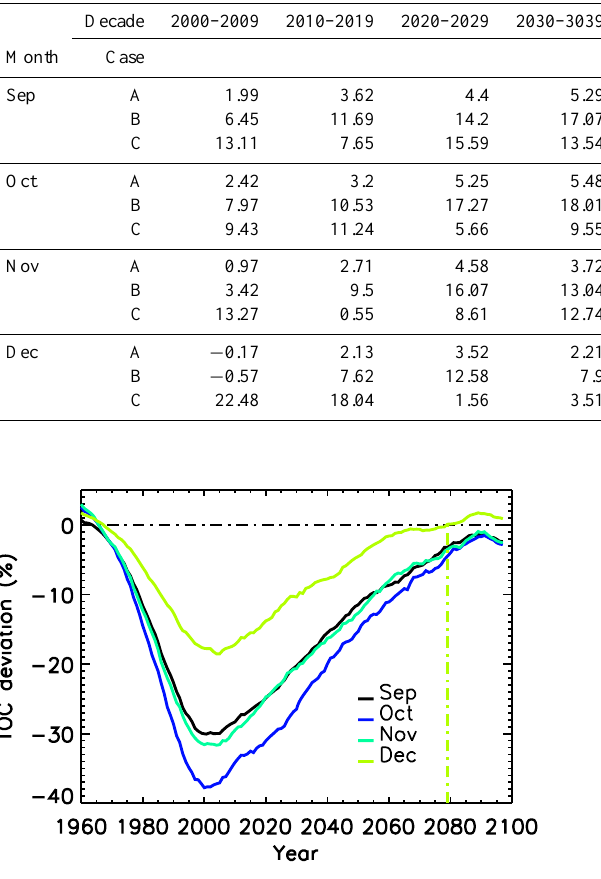
Fig. 3. Time series of multi-model TOC median values for September–December as percent deviations from the 1965 baseline. Curves have been smoothed as described in Fig. 1. TOC return dates to the 1965 baseline are shown by dashed-dotted lines, color-coded by the corresponding month.